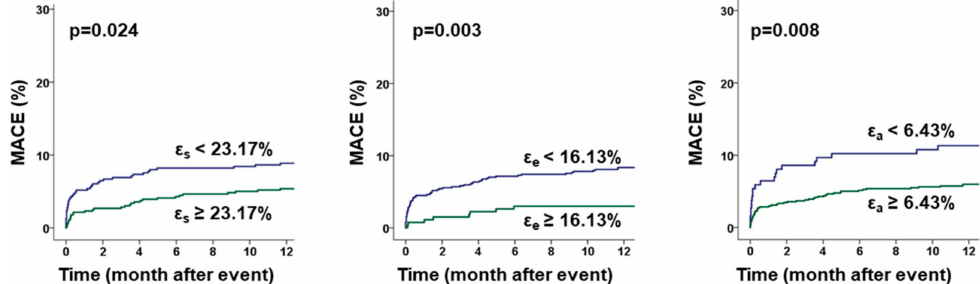
Figure 3. Influence of RA Strain on MACE prediction. The graphs show the influence of right atrial (RA) reservoir ( ε s ), conduit ( ε e ) and booster pump ( ε a ) strain on the rate of major adverse clinical events (MACE) during 12 months follow-up after ROC-adapted dichotomization, p values calculated by log-rank test.